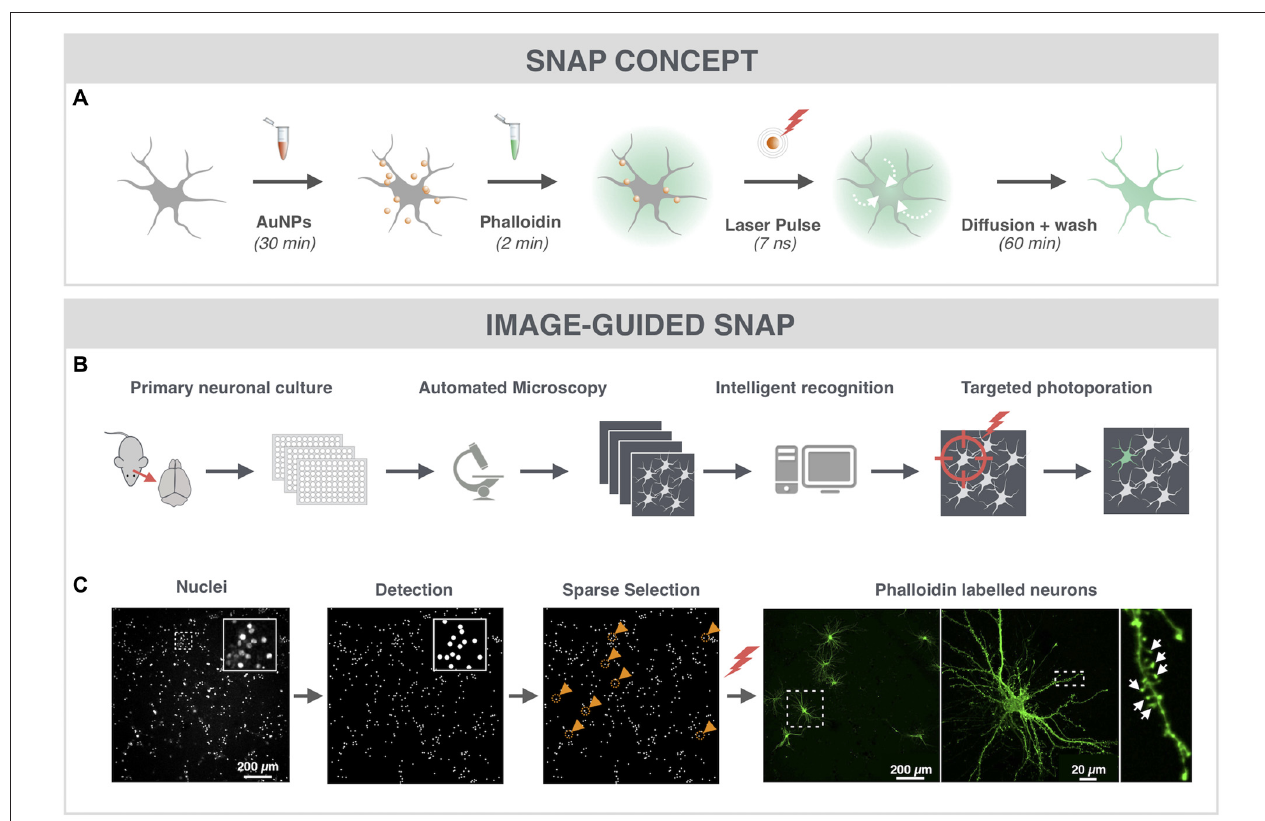
FIGURE 1 | Spatially resolved NAnoparticle-enhanced Photoporation (SNAP) enables fast and targeted labeling of primary hippocampal neurons and their spines. (A) General workflow of SNAP. Intracellular delivery of phalloidin relies on the adsorption of cell-interactive plasmonic gold nanoparticles (AuNP) to the plasma membrane. Upon selective illumination of the cell of interest with 561 nm laser light, AuNPs heat up and induce vapor nanobubbles (VNBs). These VNBs transiently open the membrane, allowing the otherwise impermeable dye to enter the soma (white arrows). After washing and allowing time for intracellular diffusion of the dye to the neuronal extremities, completely labeled neurons can be monitored with high contrast. (B) Workflow of image-guided SNAP. Before the actual SNAP procedure is initiated, large field-of-view images are acquired of cells labeled with a cell-permeable marker. After image analysis and selection, the coordinates of the cells of interest are determined and fed into the SNAP setup for targeted photoporation. (C) Image-guided SNAP on primary neurons. Nuclei are stained with the membrane-permeable dye Hoechst. Using image analysis, all nuclei are first detected, followed by a selection of nuclei that are at least 200 µ m apart (gold circles and arrowheads). The coordinates of the neurons of interest are used to guide the SNAP procedure. The high-resolution image of the phalloidin-labeled neuron shows dendritic spines (arrows) in high contrast without interference of fluorescence from overlapping dendrites or axons of nearby cells.